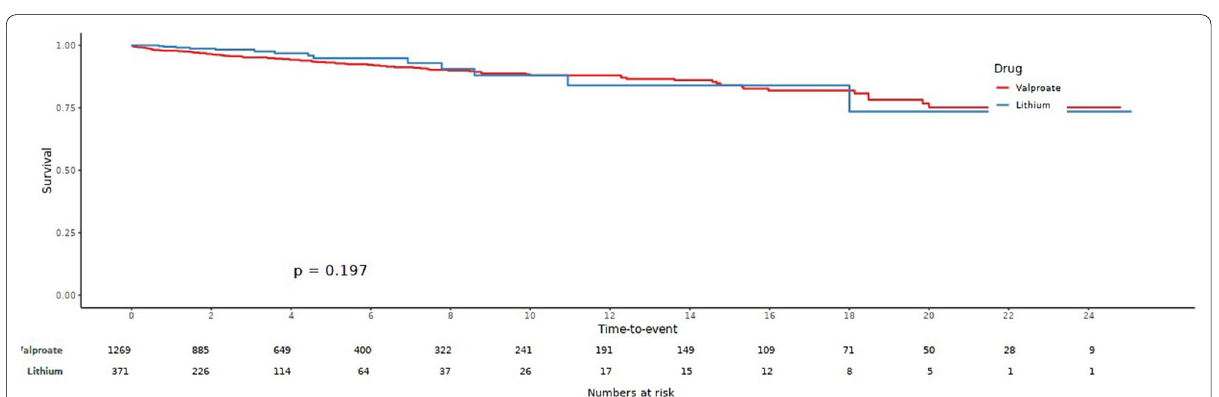
Fig. 3 Kaplan–Meier plot on years of treatment taken to enter CKD stage 3 (eGFR < 60 mL/min/1.73 m 2